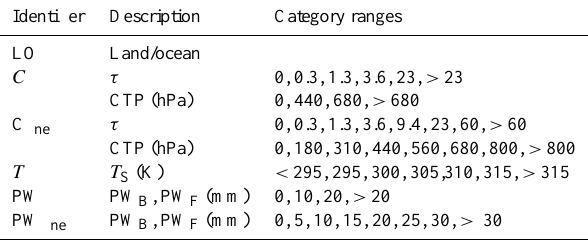
Table 2. Category values for different